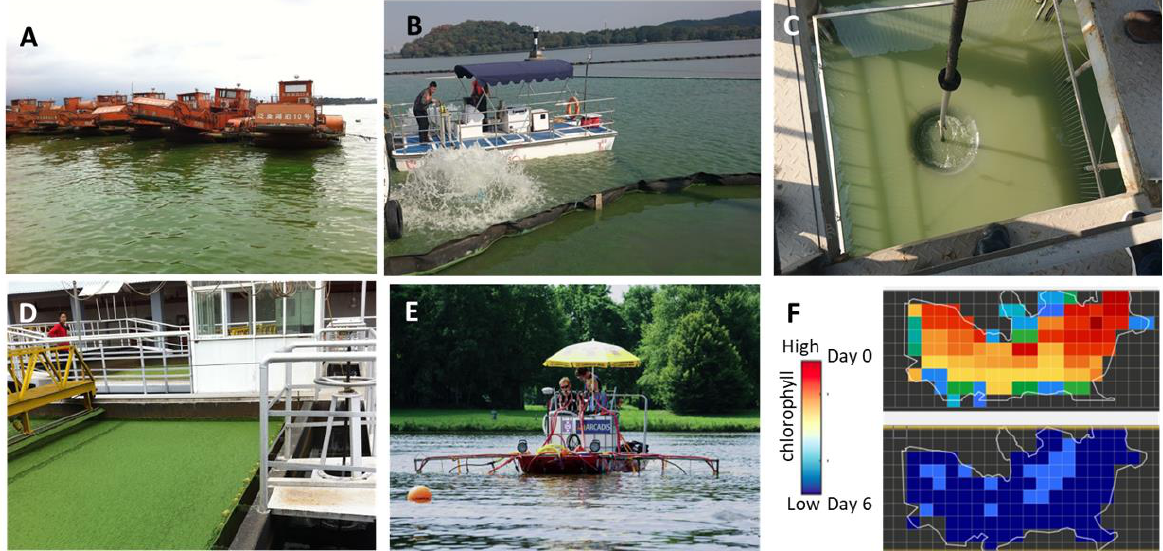
Figure 2. Various techniques used to mitigate and remove cyanoHABs from water bodies. ( A ) A fleet of boats carrying screening devices to remove Microcystis colonies (Dian Lake, Dianchi, China). ( B ) A boat carrying and operating ultrasound devices in Tai Lake, China. ( C ) An experimental pit to apply hydrostatic pressure and thereby collapse the gas-vesicles and inhibit colony floatation (taken at Lake Tai, China). ( D ) Flocculation – floatation treatment to remove biomass from Microcystis -laden water during a cyanoHAB event in Tai Lake, China. ( E ) The ‘water harrow,’ a device used to disperse hydrogen peroxide into Lake Koetshui ([65], with permission). ( F ) Chlorophyll distribution estimated from satellite spectral images of Lake Nanhu, China, at days 0 and 6 after treatment with an encapsulated floating composition containing copper sulfate (adapted from https://bgtechs.com/, with permission. Accessed date 7 July 2021).